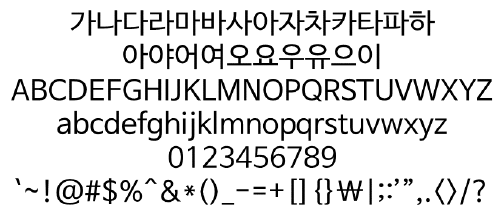
Figure 5. Nanum-Barun gothic font